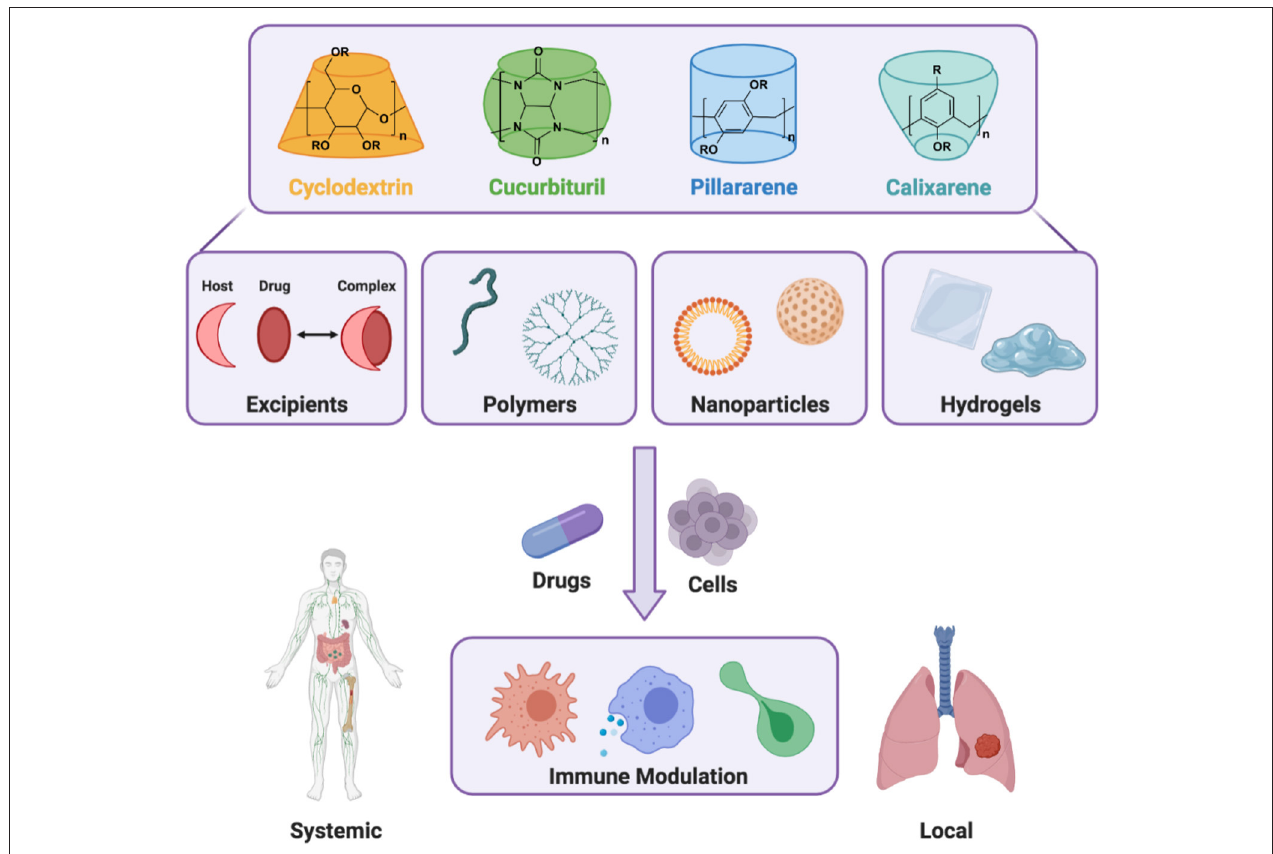
FIGURE 1 | Host macrocycles include the families of cyclodextrins, cucurbiturils, pillararenes, and calixarenes. These molecules contribute to the development of dynamic supramolecular materials, including as formulation excipients and functional building blocks for polymers, nanoparticles, and hydrogels. Through the inclusion of therapeutic cargo (drugs, cells), a range of immunomodulatory outcomes are possible that may span activity throughout the body (systemic effects) or activity at a specific location (local effects), achieved through either targeted systemic delivery or local biomaterial